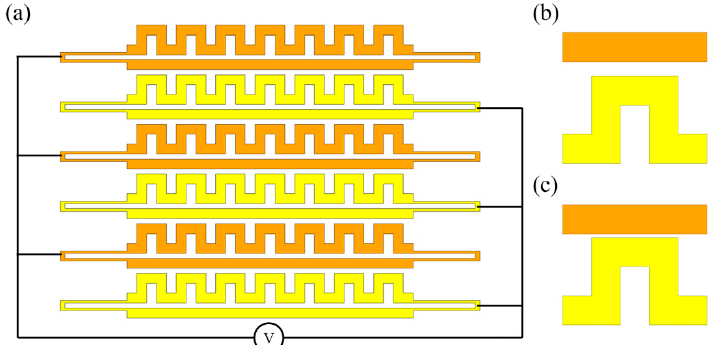
Figure 14. ( a ) Schematic of the electrostatically tunable plasmonic metamaterials. ( b , c ) The two states of a unit metamolecule.